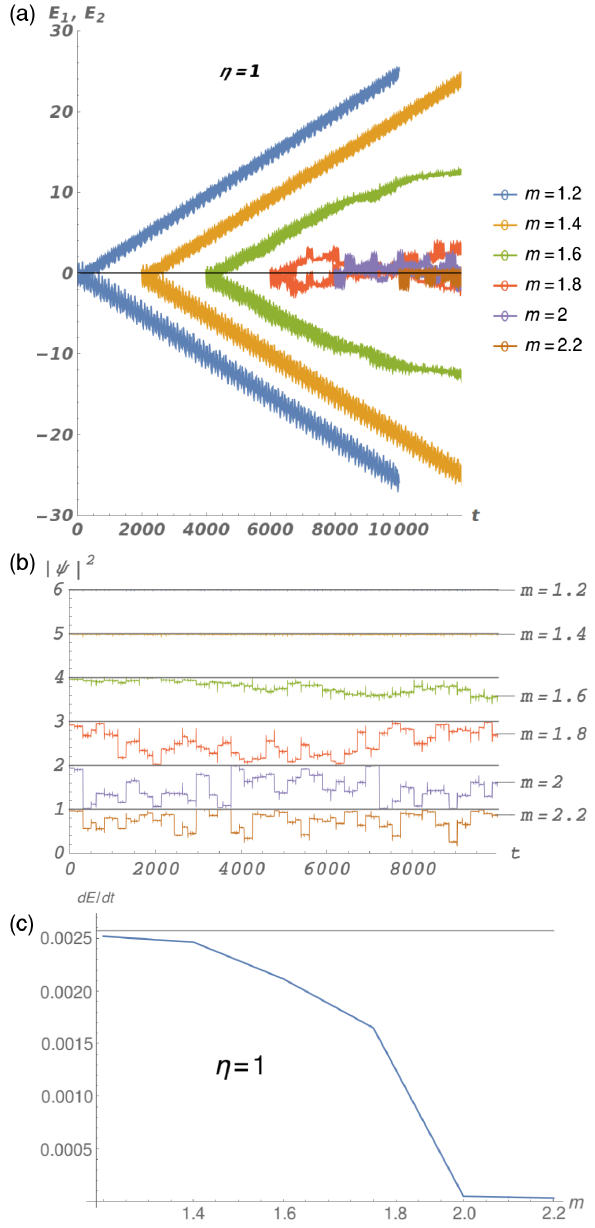
FIG. 13. Work (a) and fidelity (b) in the intermediate drive regime for η ¼ 1 . We initialized the system with the instantaneous eigenstate of H ð 0 Þ , where the initial phases for these plots are ϕ π = 10 , ϕ 0 . (c) Power pumped averaged for t < 2000 as 1 ¼ 2 ¼ a function of gap parameter m